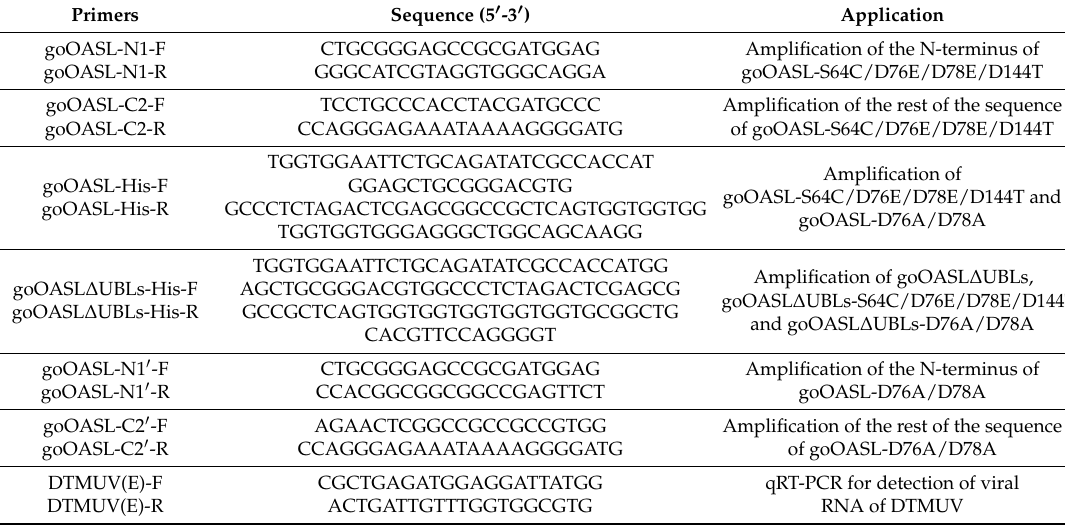
Table 1. List of